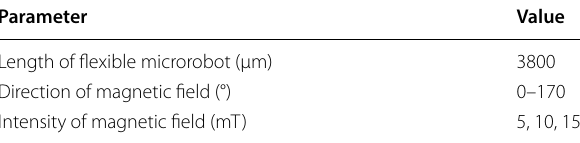
Table 3 Experimental and simulated conditions